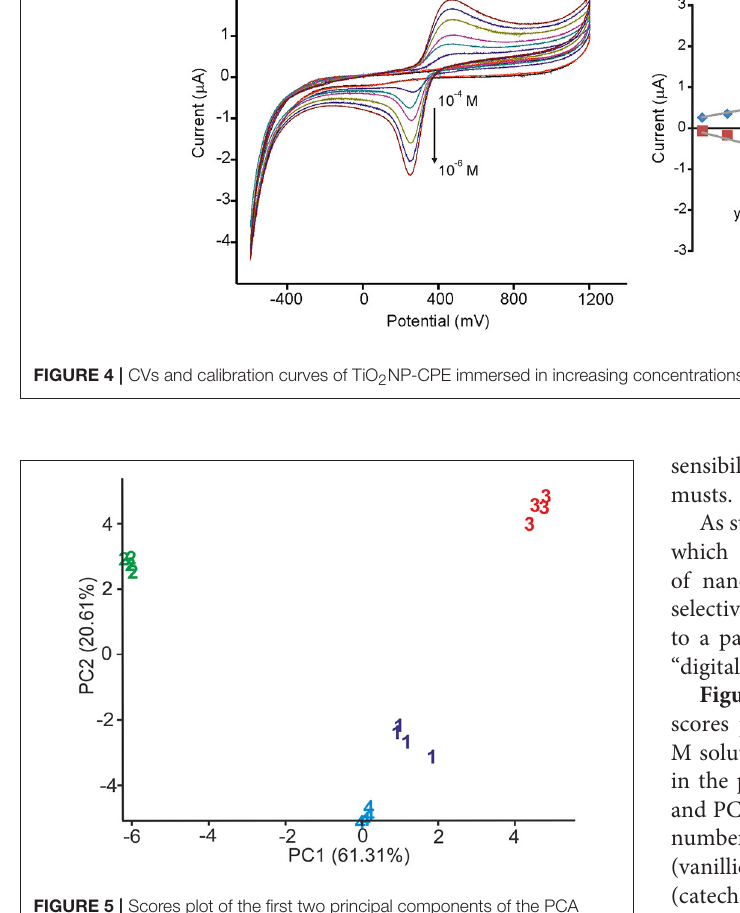
acid and catechol at the graphite electrode surface